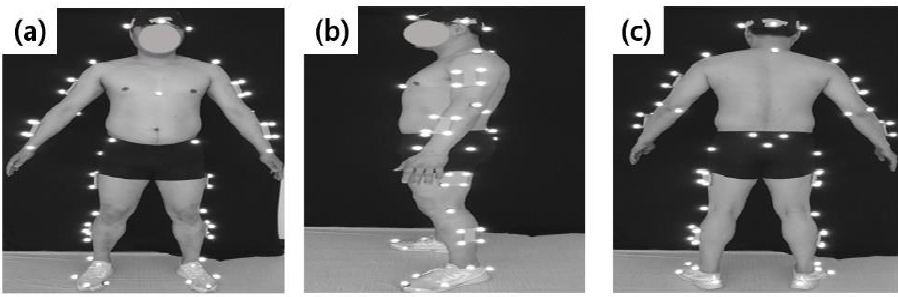
Figure 2. Reflective markers on the body: ( a ) frontal view, ( b ) lateral view, ( c ) backward view.